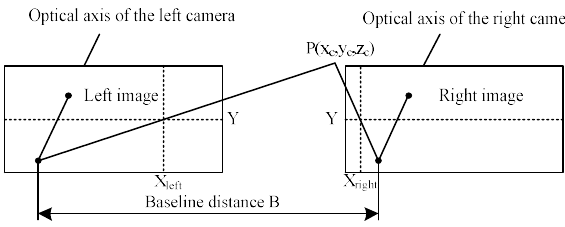
Figure 16. Principle of binocular vision.